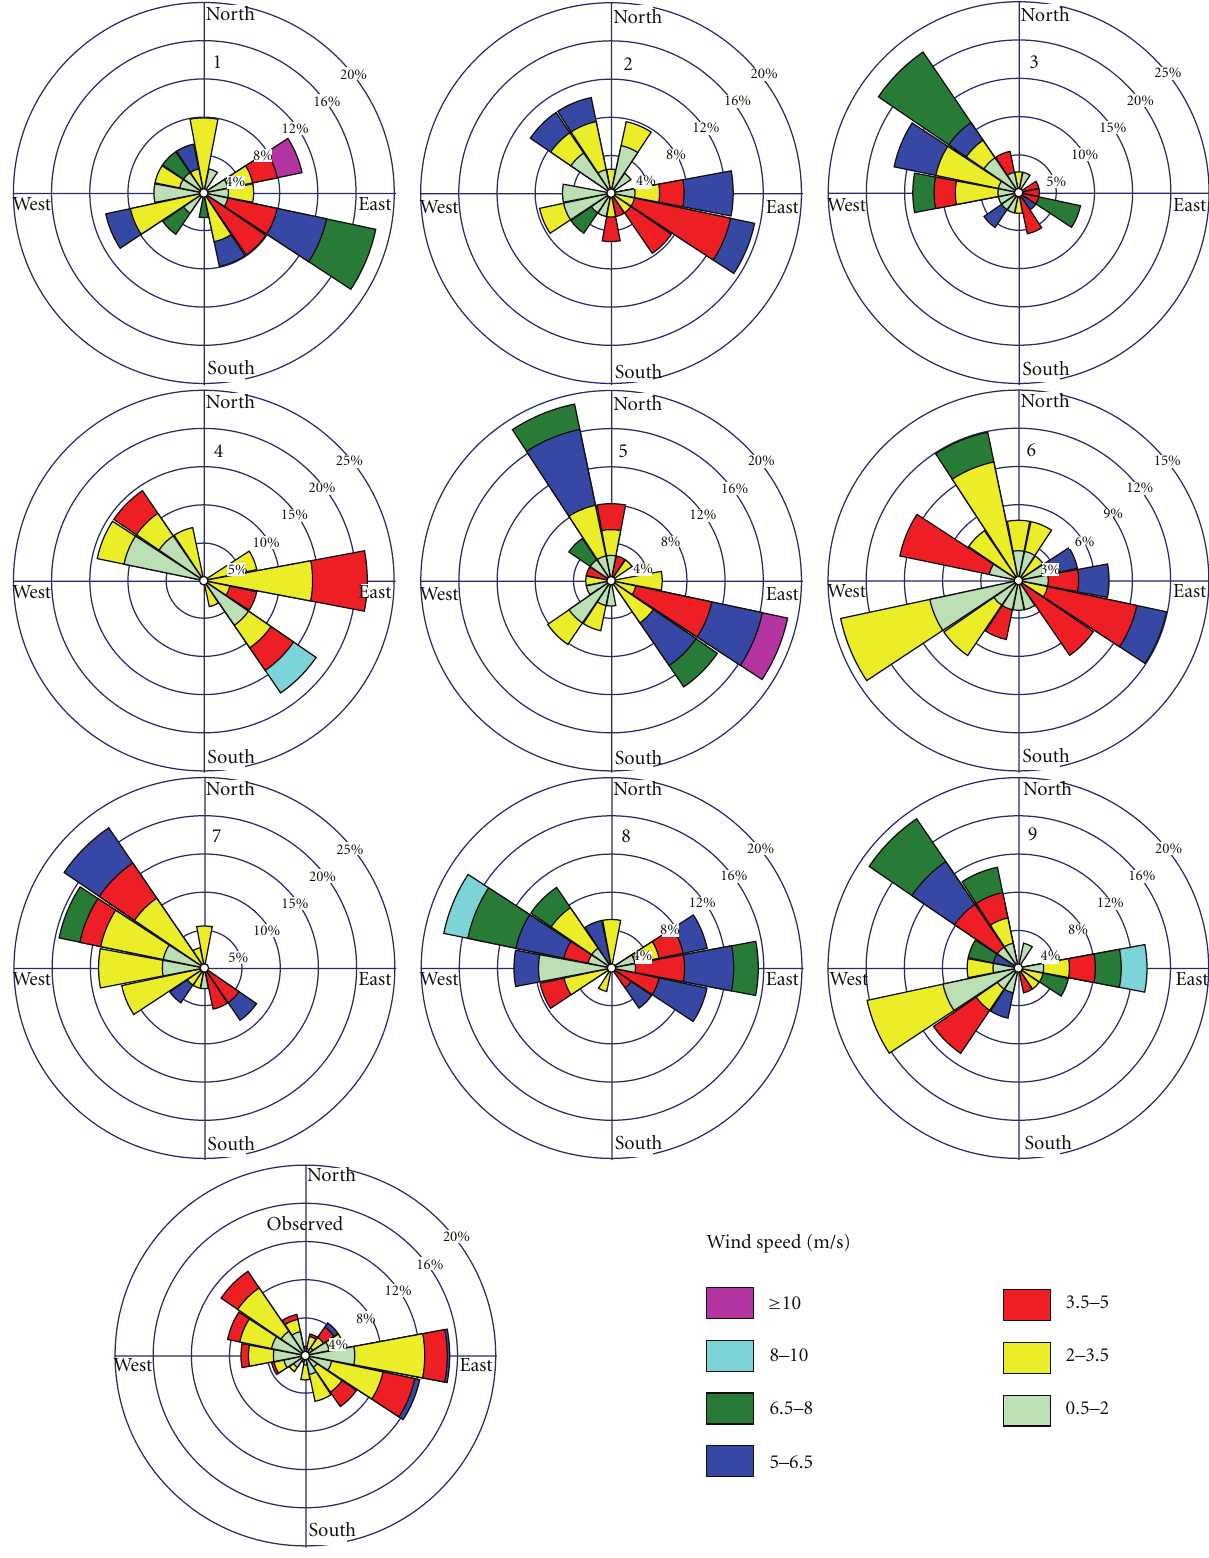
Figure 3: Wind roses for station 1 for summer